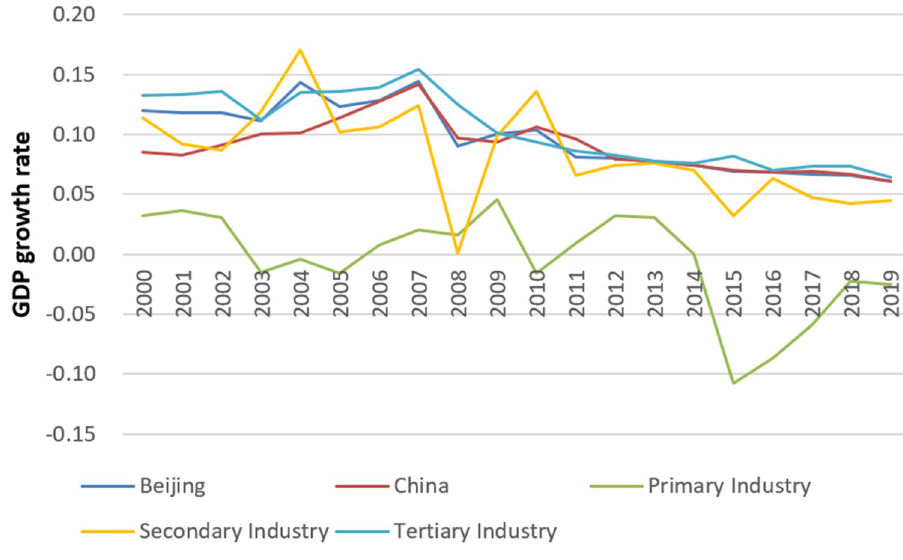
Fig 2. GDP growth of various industries in